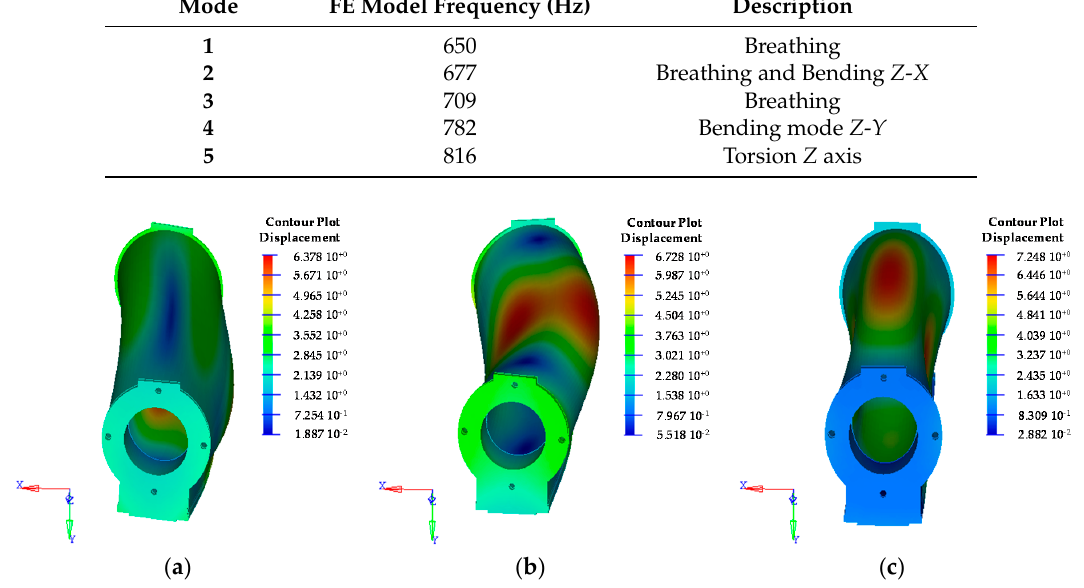
Figure 6. The FE modes 1–3 at 650 Hz ( a ); 677 Hz ( b ); and 709 Hz ( c ) performed on the AFS ram.